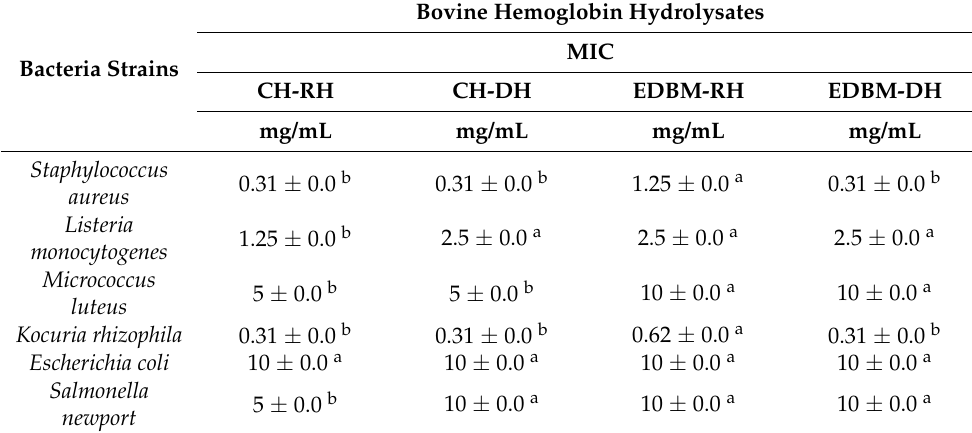
Table 2. MIC values of the bovine hemoglobin hydrolysates. Bovine Hemoglobin Hydrolysates MIC Bacteria Strains CH-RH CH-DH EDBM-RH EDBM-DH mg/mL mg/mL mg/mL mg/mL Staphylococcus 0.31 ± 0.0 b 0.31 ± 0.0 b 1.25 ± 0.0 a 0.31 ± 0.0 b aureus Listeria 1.25 ± 0.0 b 2.5 ± 0.0 a 2.5 ± 0.0 a 2.5 ± 0.0 a monocytogenes Micrococcus 5 ± 0.0 b 5 ± 0.0 b 10 ± 0.0 a 10 ± 0.0 a luteus Kocuria rhizophila 0.31 ± 0.0 b 0.31 ± 0.0 b 0.62 ± 0.0 a 0.31 ± 0.0 b Escherichia coli 10 ± 0.0 a 10 ± 0.0 a 10 ± 0.0 a 10 ± 0.0 a Salmonella 5 ± 0.0 b 10 ± 0.0 a 10 ± 0.0 a 10 ± 0.0 newport